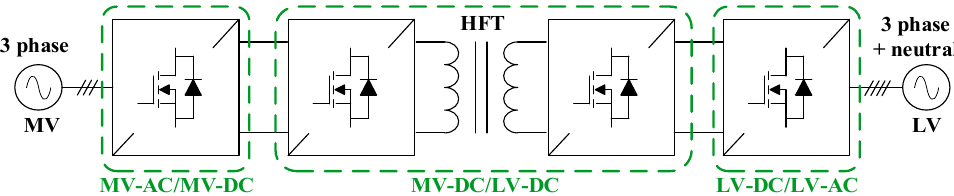
Figure 1. Block scheme of the SST consisting of three stages of power conversion with HFT.